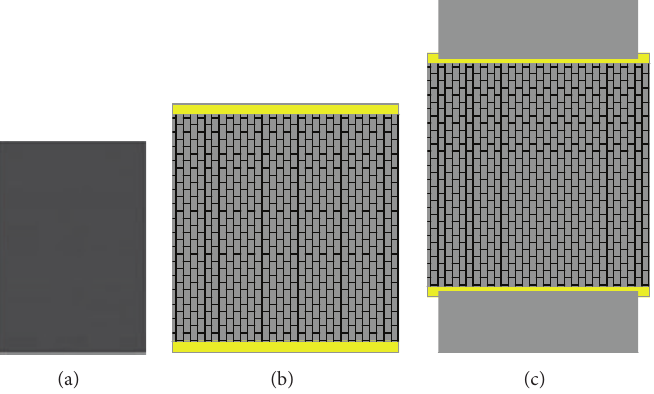
Figure 11: Key of the components schematics: (a) diode, (b) bare cell, and (c) cell with front interconnectors.